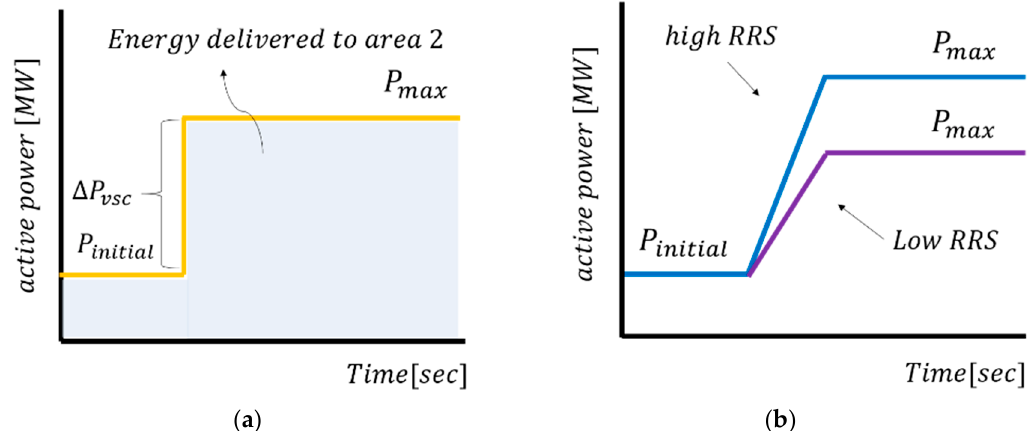
Figure 4. Two major active power control schemes: ( a ) step control ( b ) ramp-rate control with different ramp-rate slopes (RRSs).